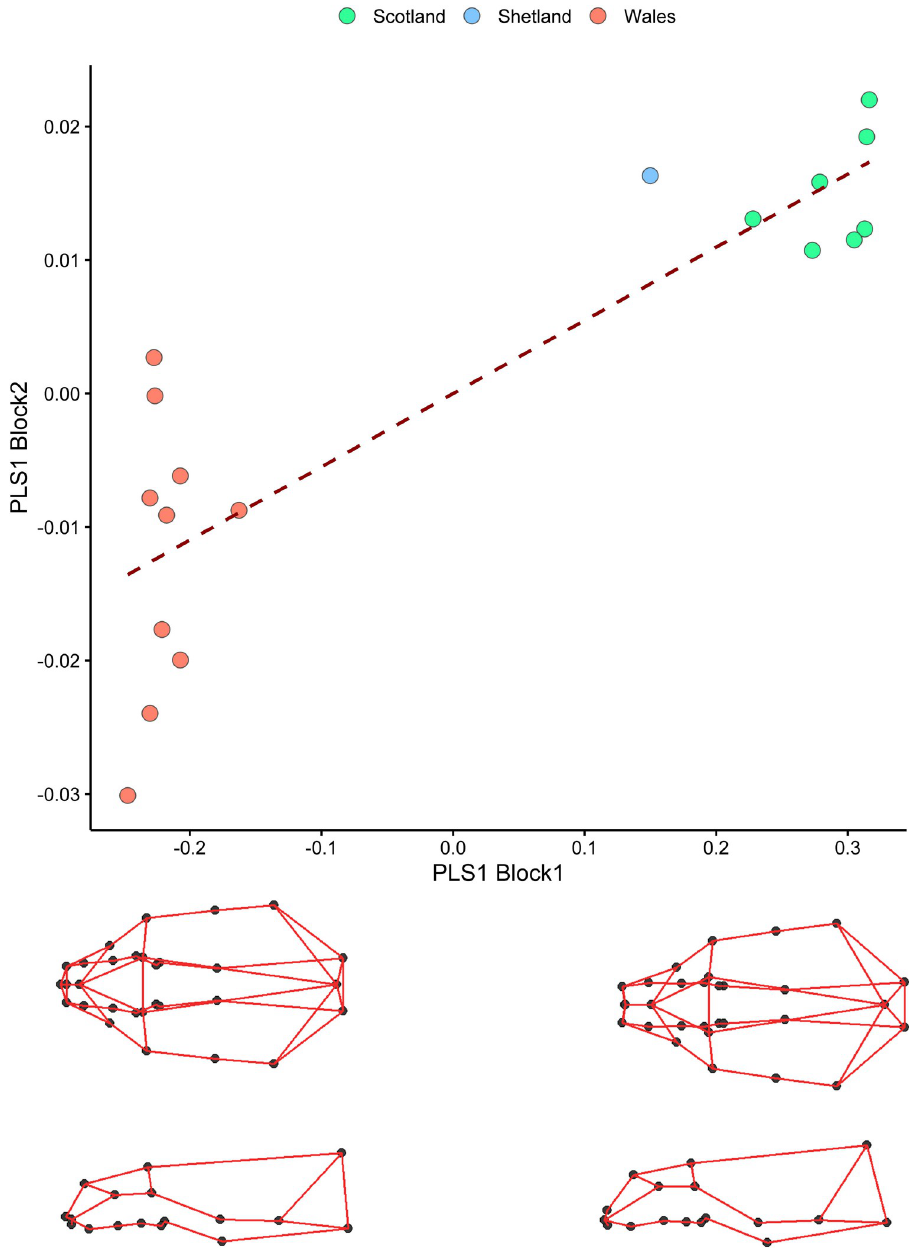
Fig 7. Association between skull shape and climate. Each point indicates one of the 18 sampling locations; colours indicate the genetic clusters. Data represent PLS scores from Block1 (representing mean shape variables for each sample locality) and Block2 (climate variables). Below the x-axis are shown the wireframes corresponding to shape changes at the extremes of the axis. Nodes represent the landmarks, edges the anatomical connections between